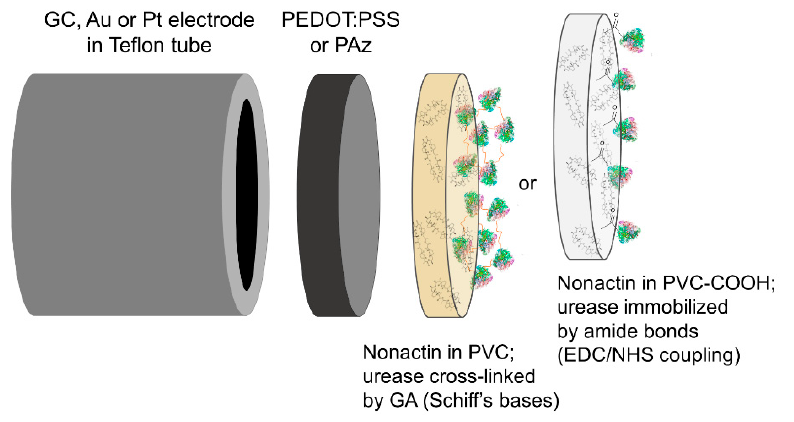
Figure 1. General construction of the urea biosensor.